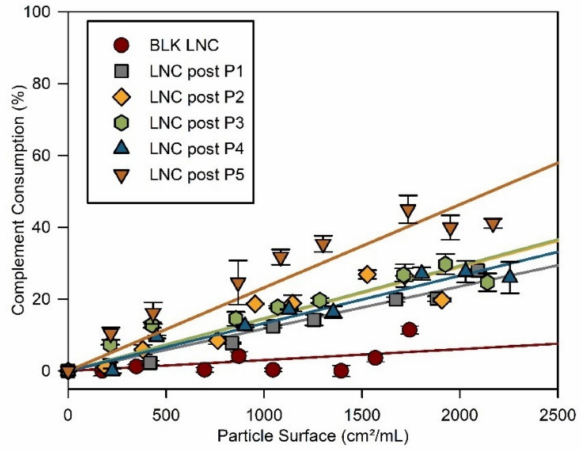
Figure 4. Complement consumption at 37 ◦ C of blank LNC (“BLK LNC”) (red circle) and LNC post inserted by C 18 H 37 -PNVP 49 (“LNC post-P1”), C 18 H 37 -P(NVP 15 -co-Vim 5 ) (“LNC post-P2”), C 18 H 37 - P(NVP 22 -co-Vim 8 ) (“LNC post-P3”), C 18 H 37 -P(NVP 35 -co-Vim 10 ) (“LNC post-P4”) and C 18 H 37 - P(NVP 21 -co-Vim 15 ) (“LNC